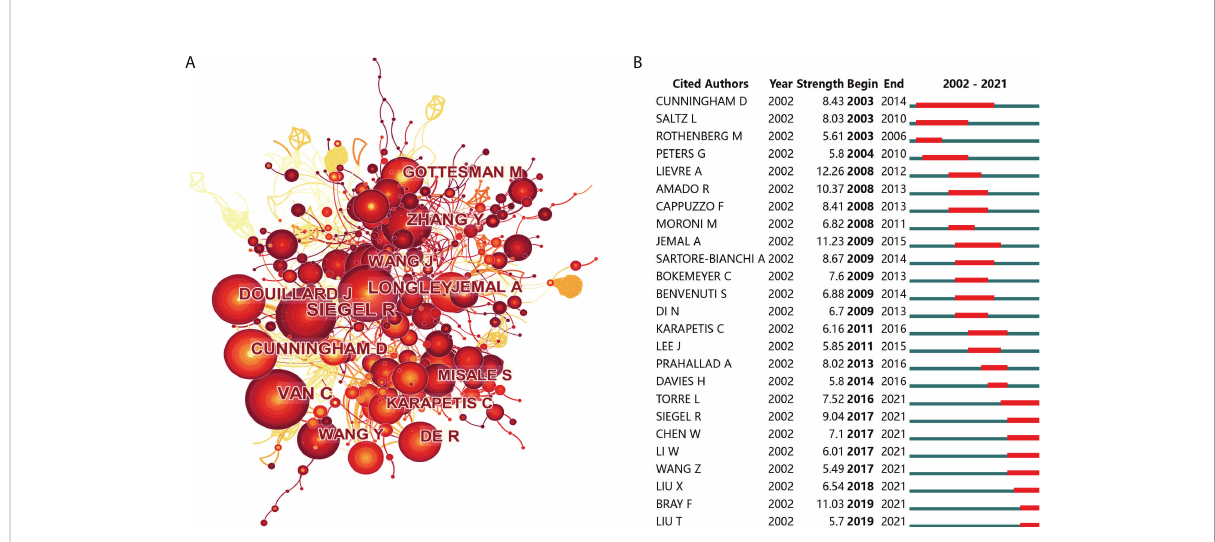
FIGURE 6 The contributions of authors in drug resistance and colorectal cancer. (A) Authors co-citation analysis. The nodes represent authors, and the lines mean citations between them. The publication number is proportional to the size of nodes, and the thickness of the connecting line is proportional to the degree of citations. (B) Top 25 authors with the strongest citation bursts. The blue line represents the time axis, and the red portion on the blue time axis represents the interval at which the burst was found, including the start year, end year, and burst duration.